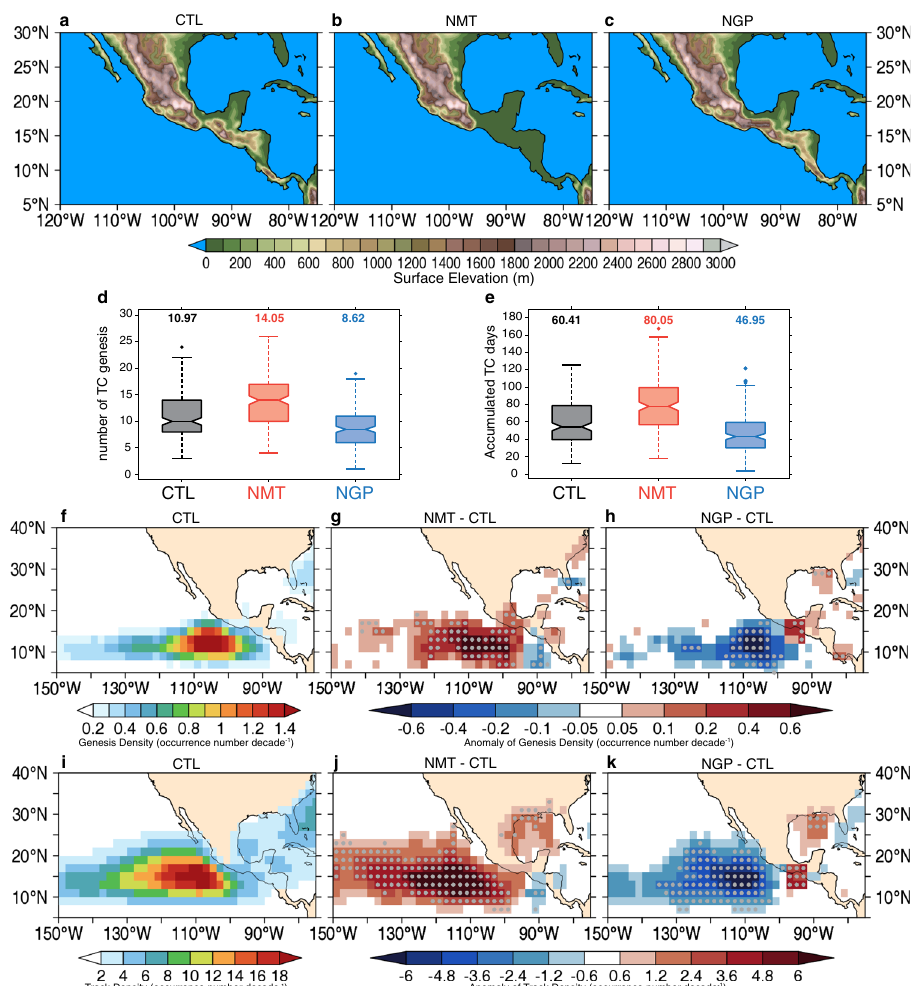
Fig. 2 Seasonal TC activity variations due to topography. Topography (m) used in a control (CTL), b no mountains (NMT), and c no mountain gaps (NGP) experiment. Boxplot of seasonal accumulated eastern North Paci fi c (ENP; 180°W to the North American coast, 0 – 30°N). d Number of TC genesis and e number of days with TC activity, showing the fi rst quartile, median, and third quartile among CTL, NMT, and NGP simulations. The dashed vertical lines show the lowest and highest datum still within the 1.5 interquartile range (IQR), and the notch displays the con fi dence interval around the median. Outliers are denoted by dots, and the number on the top of each box indicates the mean value for that set of experiments. f CTL ensemble mean of seasonal TC genesis density (occurrence number decade − 1 ) and the differences using g NMT minus CTL and h NGP minus CTL. i – k Are similar, but for the TC track density (occurrence number decade − 1 ). Gray dots denote statistical con fi dence at the 95% level based on the two-sided t